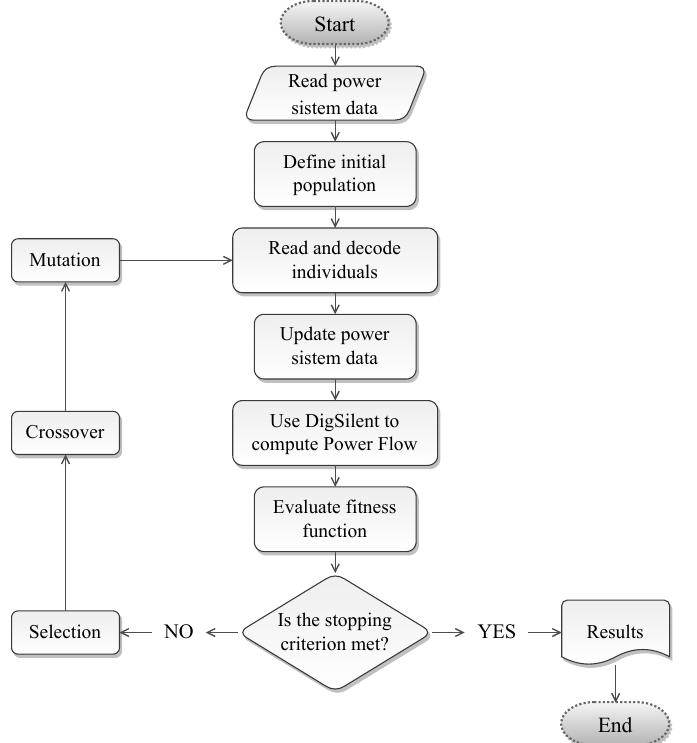
Figure 4. Flowchart of the implemented GA.